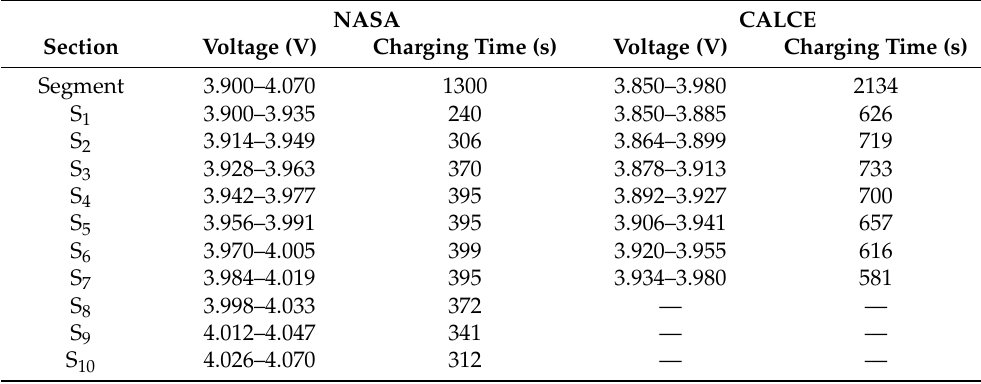
Table 1. Details of divided small voltage